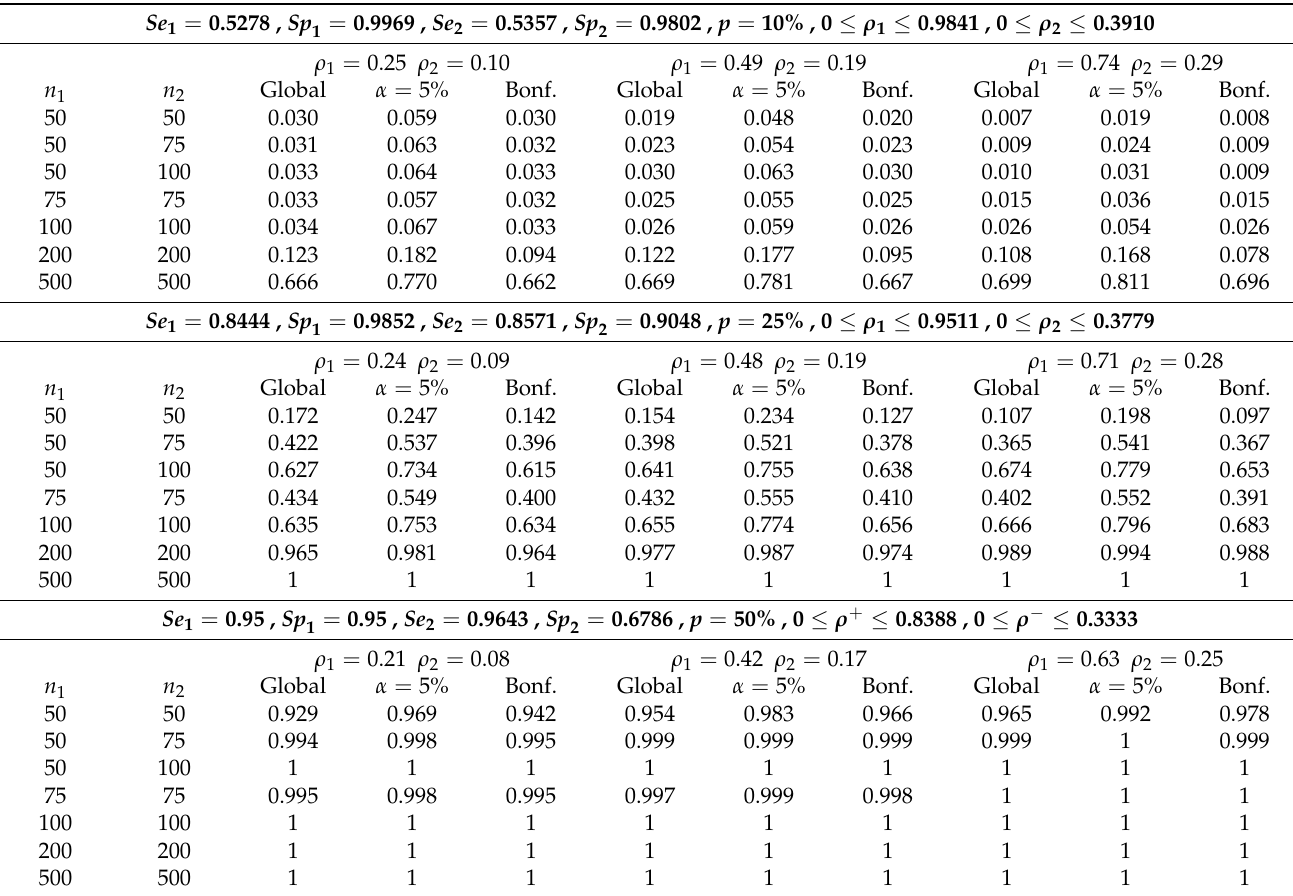
Table 5. Powers for PPV 1 = 0.95 NPV 1 = 0.95, PPV 2 = 0.75 and NPV 2 =